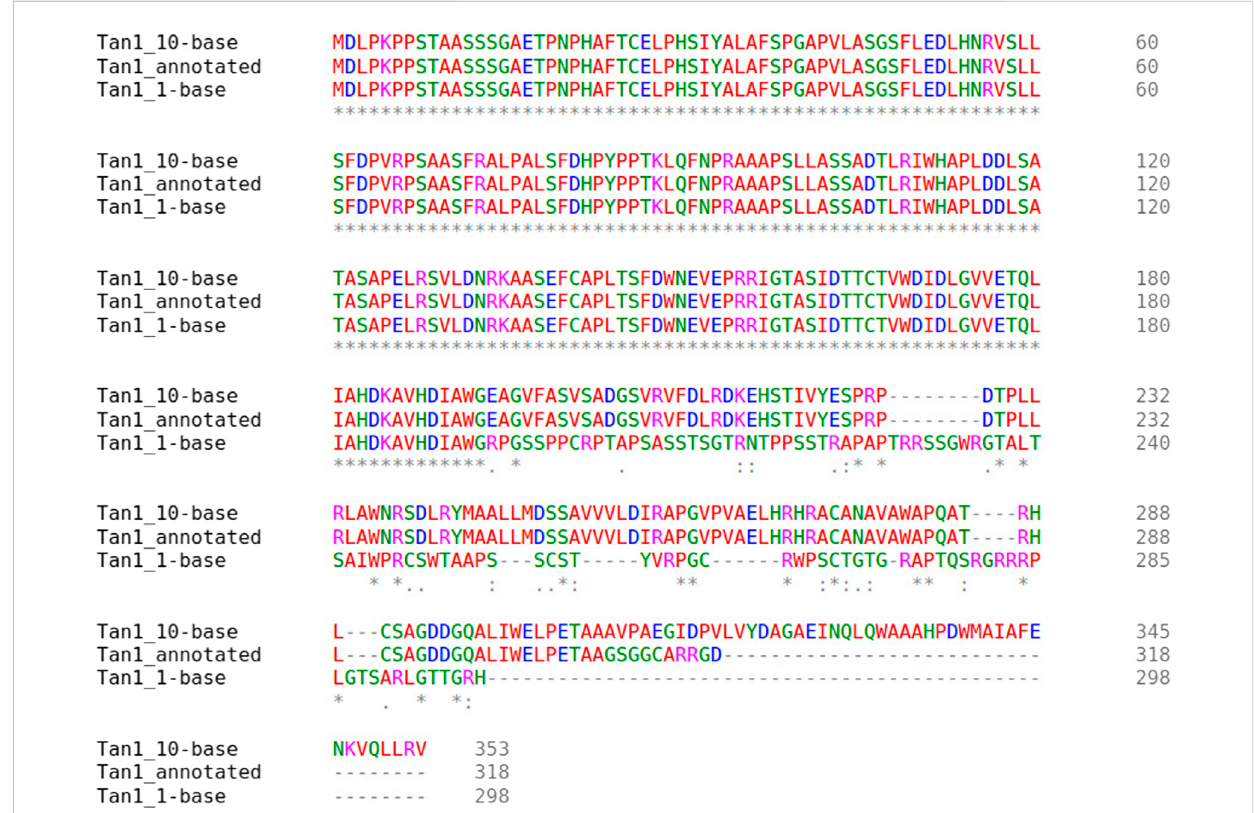
FIGURE 6 Multiplesequencealignmentofthe Tan1 alleles.Theallelenamesincludethe Tan1 allelewitha10-bpdeletion(Tan1_10-base),1-bpdeletion(Tan1_ 1-base), and the BTx623 version 3.1.1 annotated protein (Tan1_annotated). Consensus symbols include asterisks, which indicate positions with fully conserved residues, colons, which indicate conservation among amino acids with strongly similar properties, and periods, which indicate conservation between groups with weakly similar properties. Positions without consensus symbols represent non-conserved substitutions or deletions.